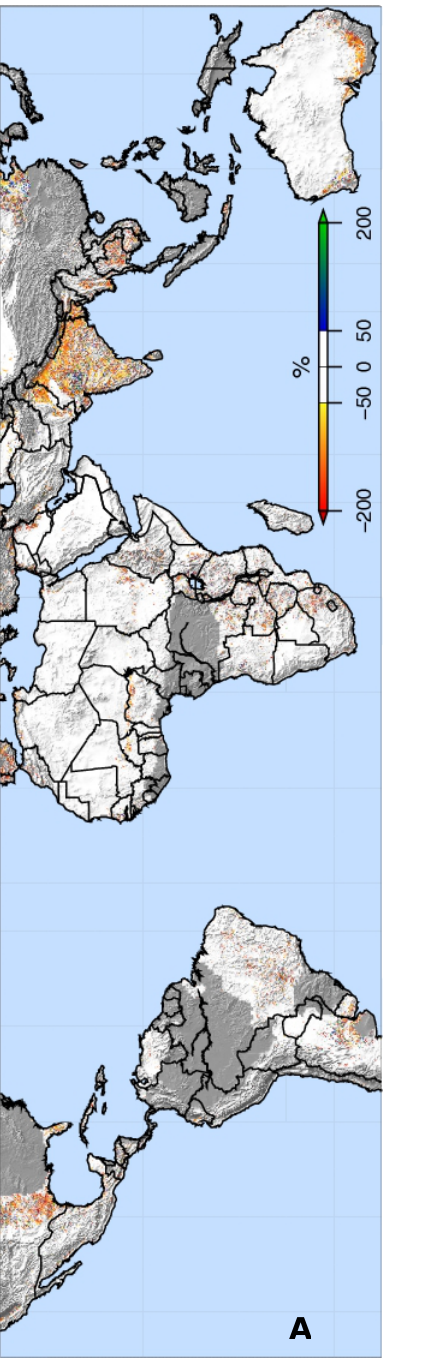
Figure 3. Distribution of changes in growth rate (%) of cropland iNDVI for the period 1996–2006 compared to the period 1982–1992 in the WLT croplands. (A) All pixels with more than ±50% change in growth rate of cropland iNDVI. (B) Only statistically significant pixels ( p <